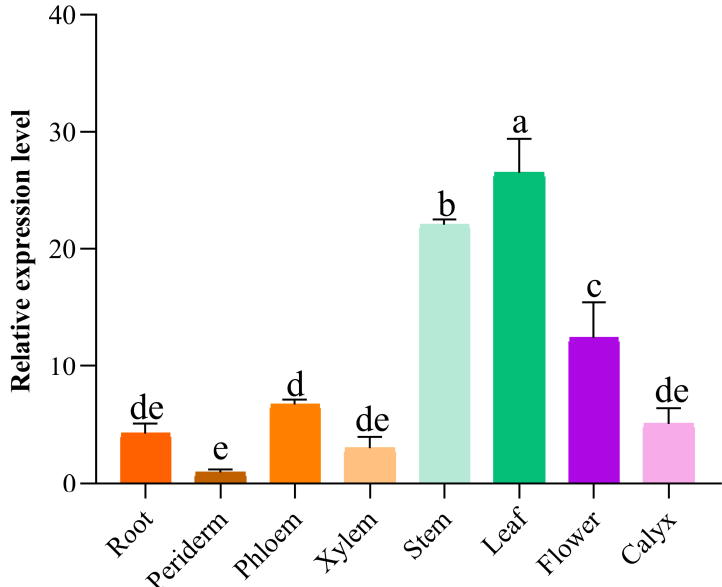
Figure 1. Expression profiles of SbMYB12 in different tissues of S. baicalensis . The data represent the means of three biological replicates, and the error bars indicate the standard deviation (SD). Significant differences between means were identified (depicted by different letters; p < 0.05) using one-way ANOVA (followed by Tukey’s comparisons).